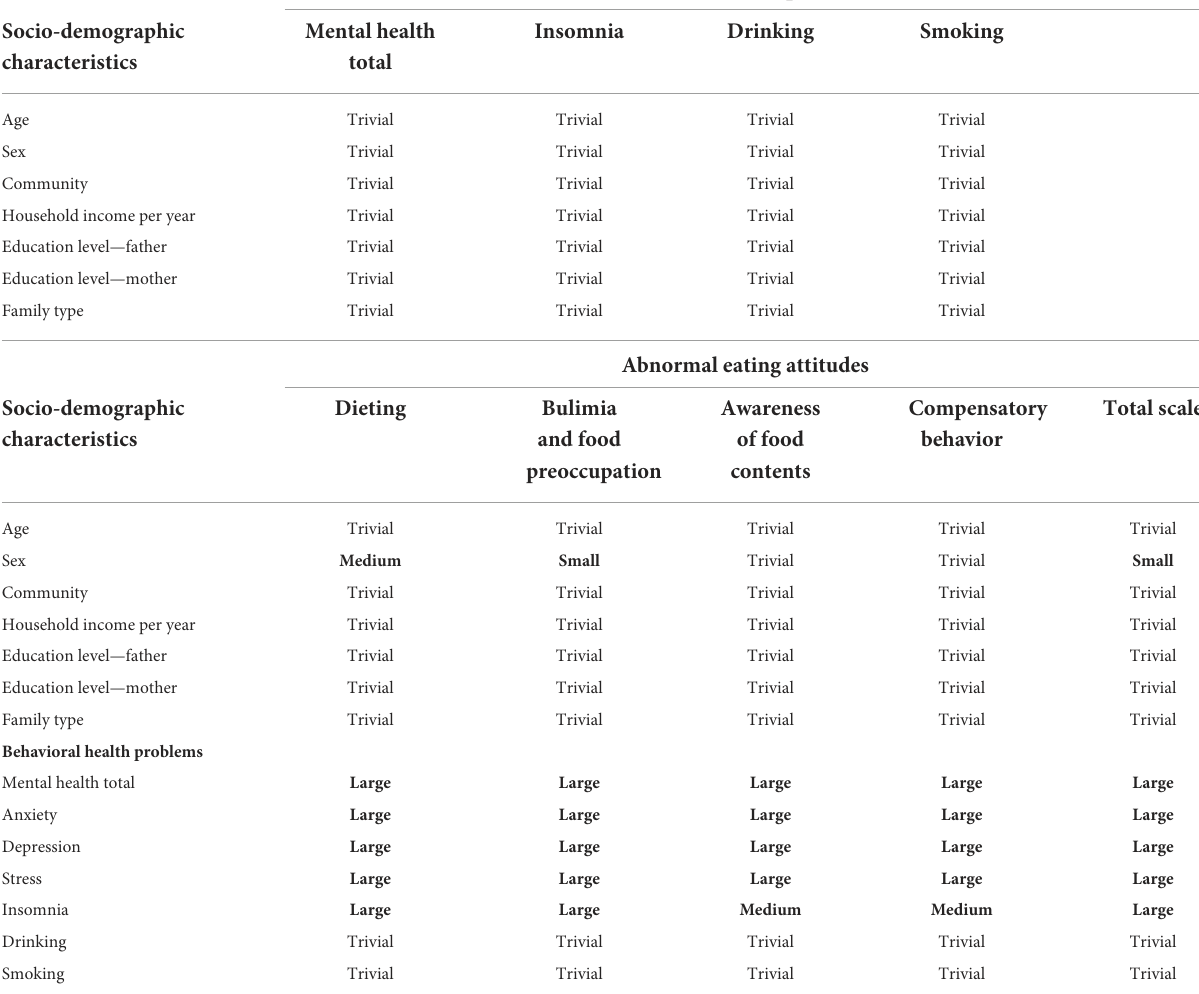
TABLE 5 Summary of statistical effect size results for all correlational